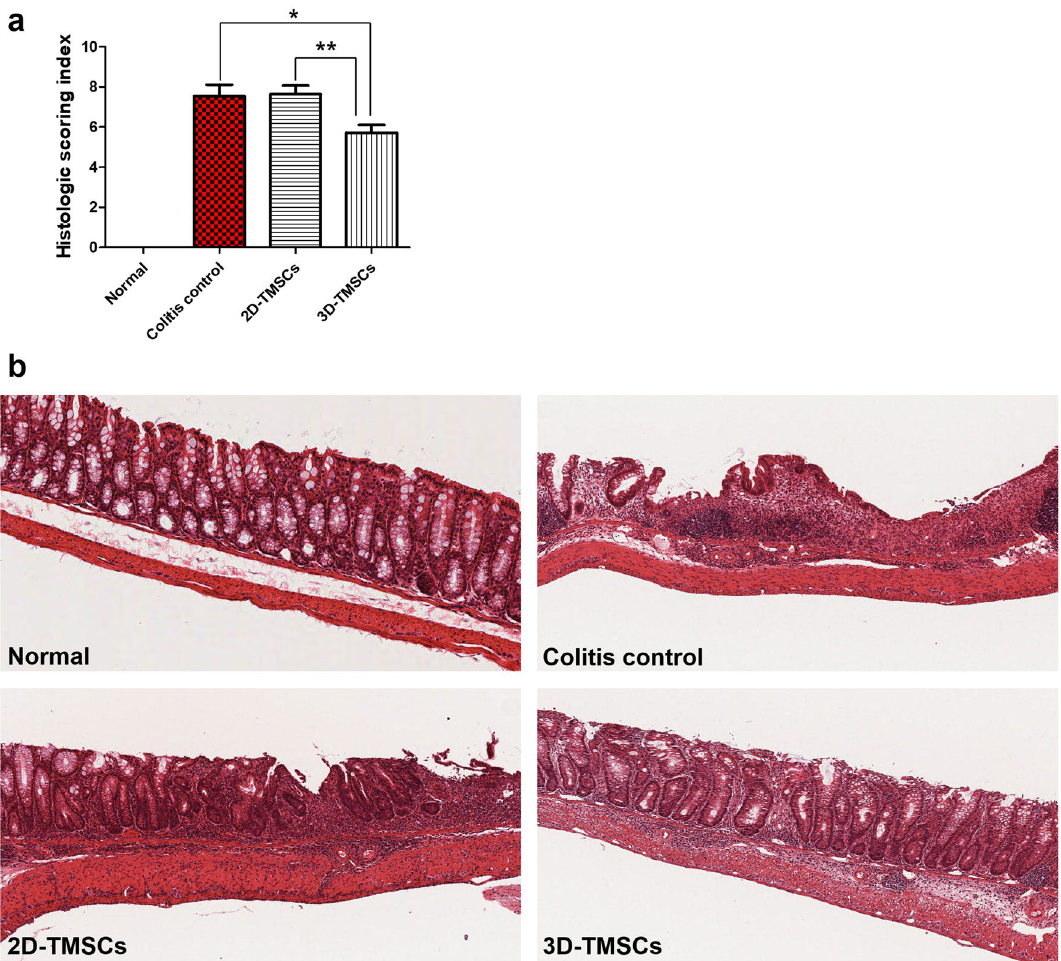
Figure 8. Histopathological recovery after treatment with 3D-cultured TMSCs. ( a ) Histopathological scoring index showed significant recovery in the 3D-TMSC-treated group when compared with the colitis control. ( b ) Histological results of colon in each group. [Hematoxylin–eosin (H&E) stain, ×100] *P < 0.05, **P < 0.005. 3D, three-dimensional; TMSCs, tonsil-derived mesenchymal stem cells; PBS, phosphate-buffered